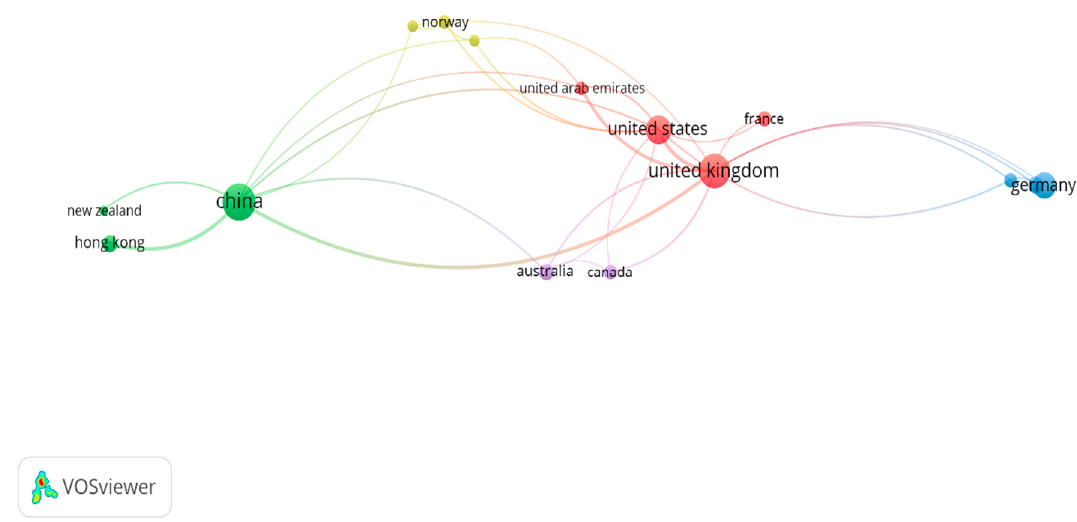
Figure 4. International collaborations in DT research in the CI. Table 5. Variation in publications among active countries in DTs in construction industry research. Country Papers Citations Total Link Strength